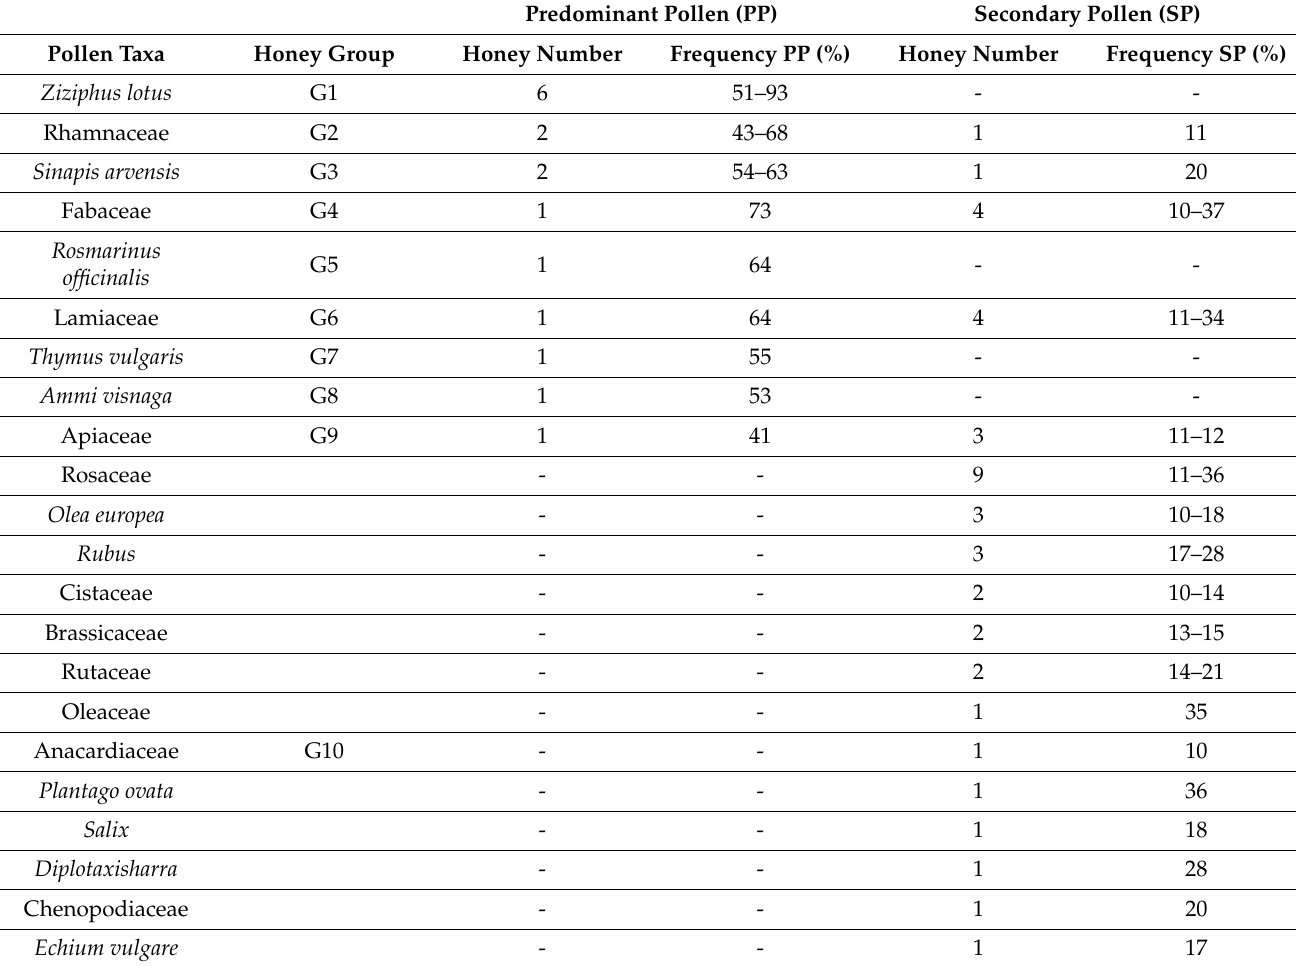
Table 2. Frequency of distribution of taxa in the 23 analyzed